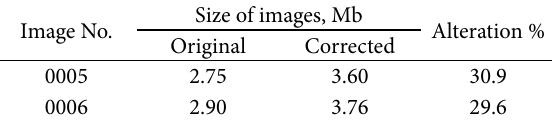
Table 2. Sizes of digital images after correction Image No.